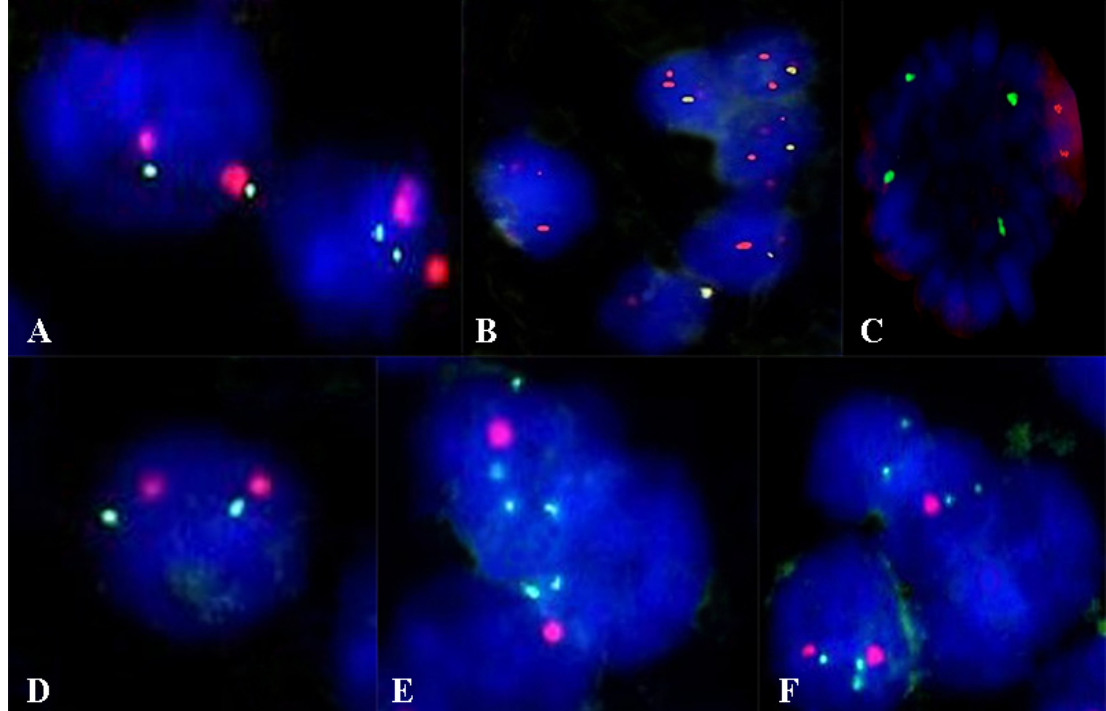
Figure 1. Aspects of the FISH examination in the evaluation of the CDKN2A gene ( A – C ) and the 1p/19q codeletion ( D – F ). ( A ). Normal status of the CDKN2A gene. ( B ). Deletion at the level of the CDKN2A gene. ( C ). Amplification at the level of the CDKN2A gene. ( D ). Normal status. ( E ). Deletion at the 1p36 locus. ( F ). Deletion at the 19p13 locus. Magnification ×1000.